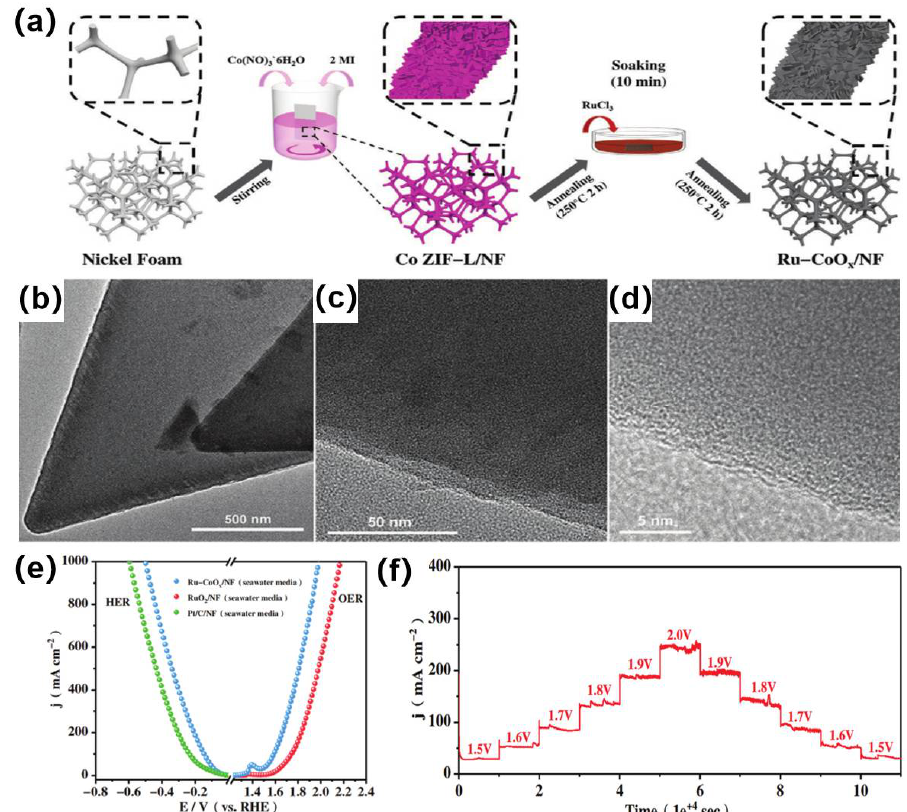
Figure 9. ( a ) Schematic representation of the synthesis of Ru-CoO x /NF, ( b – d ) TEM images of Ru- CoO x /NF, ( e ) polarization curves of Ru-CoO x /NF in seawater, and ( f ) multipotential stability test chart of Ru-CoO x /NF in seawater media. Reproduced with permission from [98]. Copyright © 2021, Wiley-VCH GmbH.